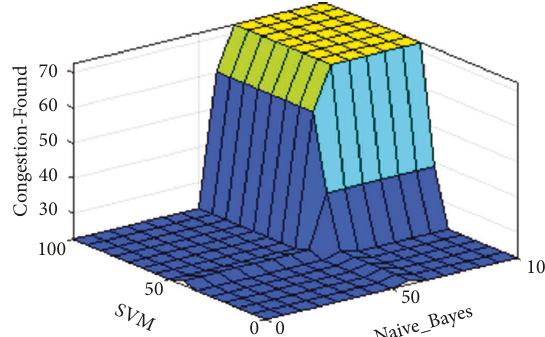
Figure 2: Rule surface of the proposed 5G congestion control